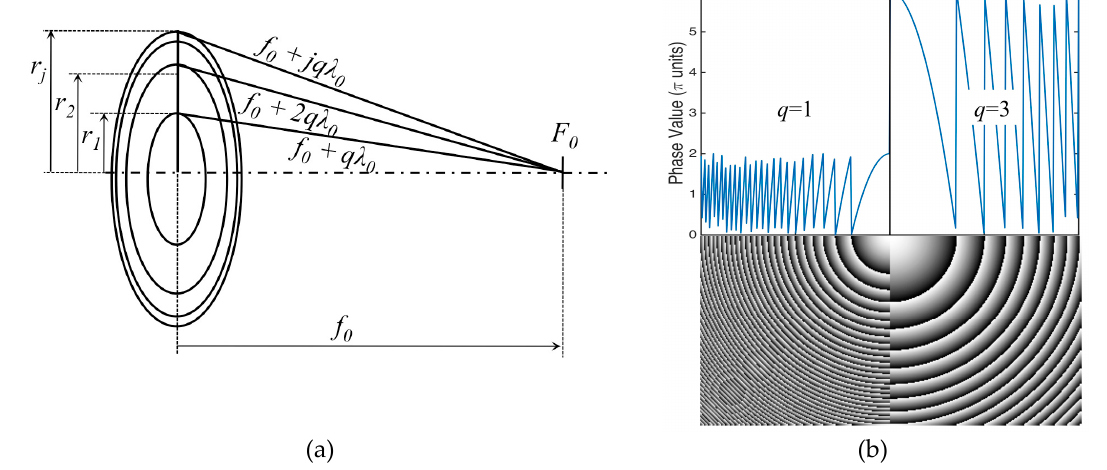
Figure 1. ( a ) Zone construction of a multiorder ( q th-order) diffractive lens whose optical path difference (OPD) between consecutive zones is q integer times the design wavelength λ 0 . ( b ) Profiles for a diffractive lens with 2 π rad ( q = 1) and 6 π rad ( q = 3) phase modulation depths.